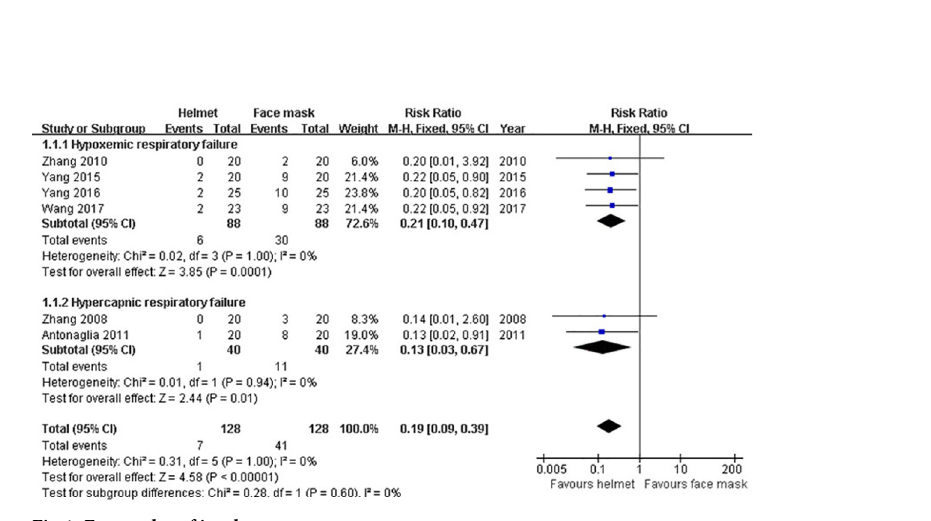
Fig 4. Forest plot of